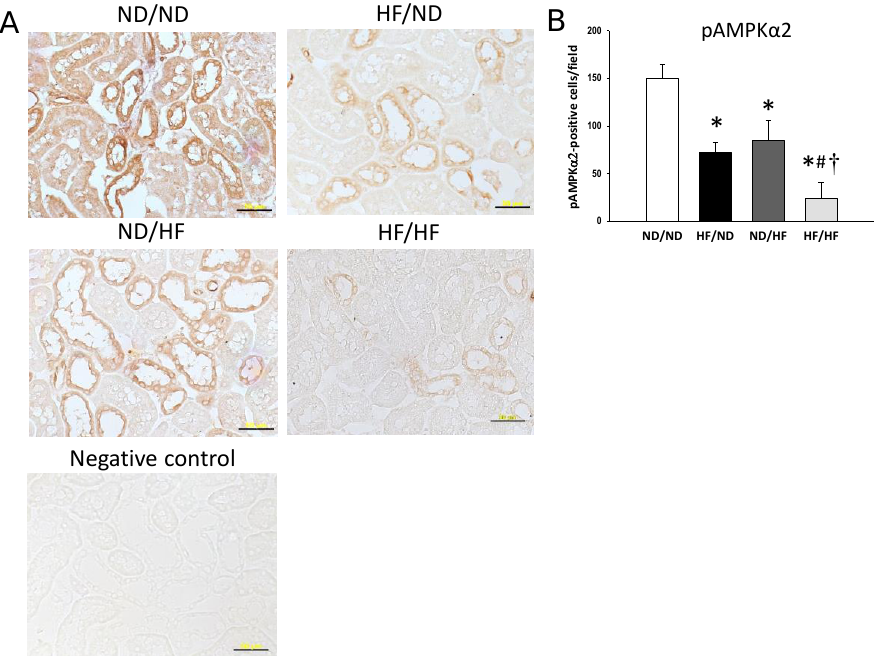
Figure 3. ( A ) Light microscopic findings of phosphorylated AMPKα2 immunostaining in the kidney cortex in 16-week-old male offspring. Bar = 50 μm; ( B ) Quantitative analysis of phosphorylated AMPKα2 -positive cells per microscopic field (400×); * p < 0.05 vs. ND/ND; # p < 0.05 vs. HF/ND; † p < 0.05 vs. ND/HF.